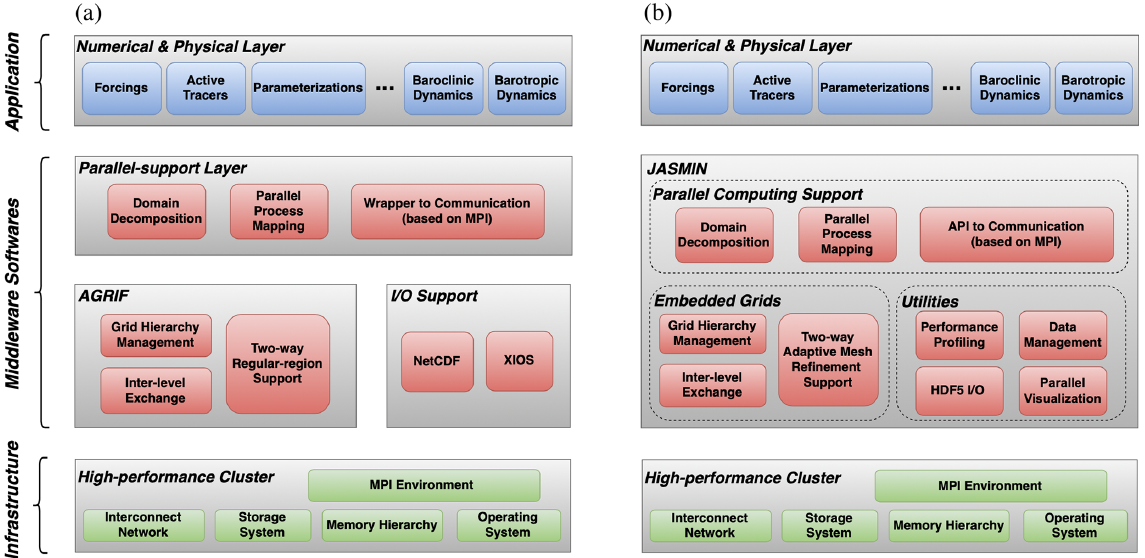
Figure 1. Model structure of NEMO (a) and OMARE (b) . The model physics and numerical algorithms (i.e., application, top layer) and computational infrastructure (bottom layer) are the same between NEMO and OMARE. The software implementation and supportive mid- dleware (middle level) are reorganized and refactored for NEMO with the JASMIN framework. The model developer is shielded from many of the technical details, including domain decomposition, adaptive refinement, and model input/output.